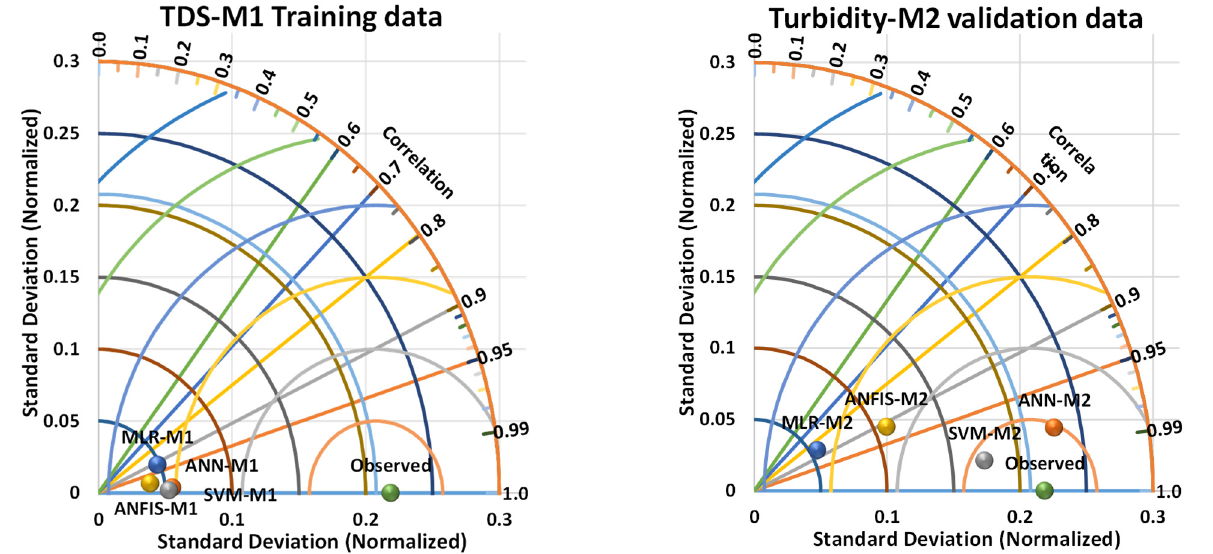
Figure 9. Two-dimensional Taylor diagram between the observed and predicted TDS in the valida- tion phase.